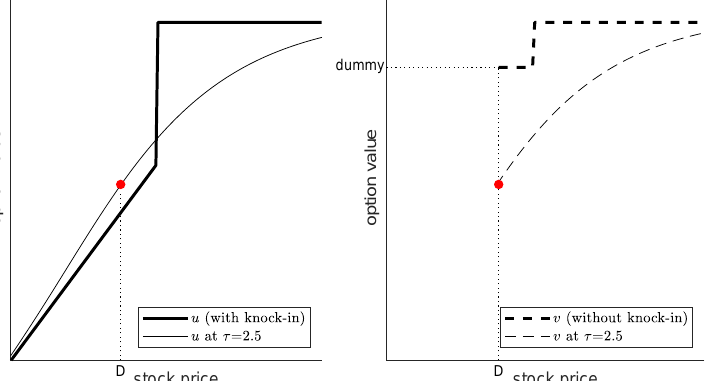
Figure 3. Schematic illustration of u and v at τ =